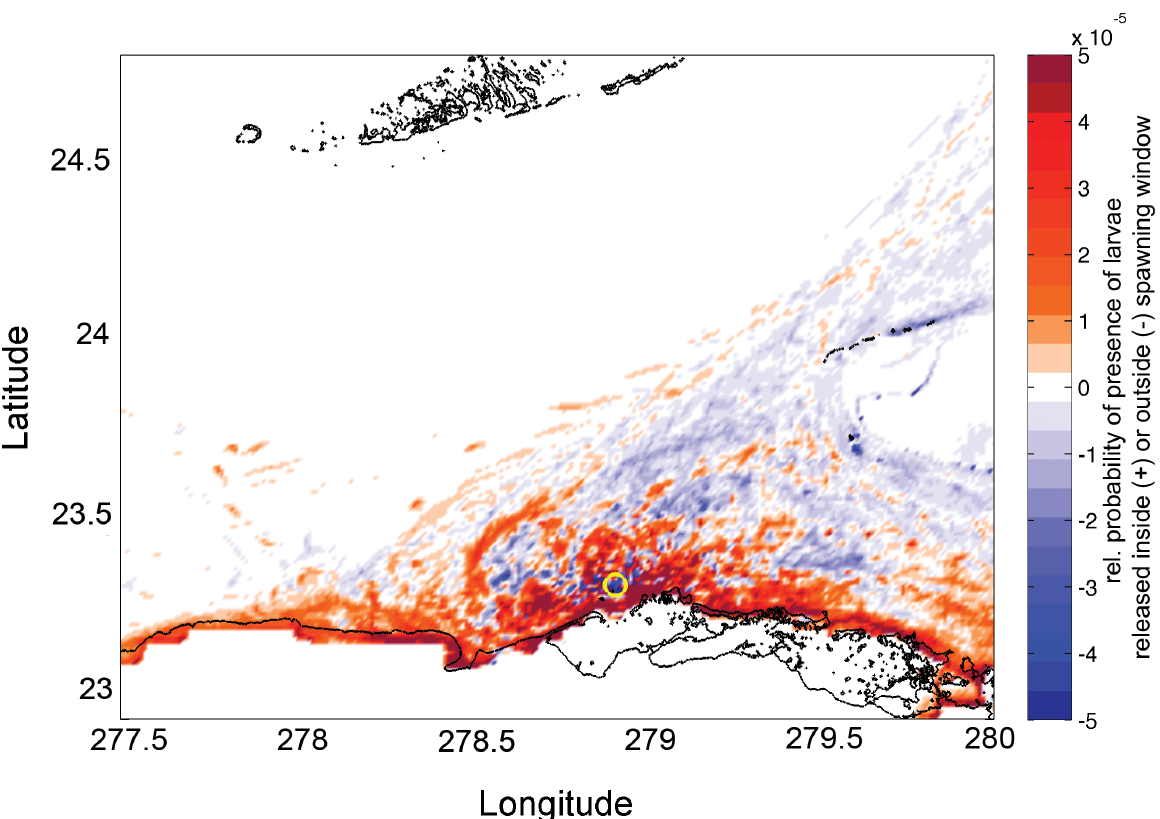
Fig 5. Difference in the dispersal kernels for larvae released inside and outside the spawning window. Color indicates the log of probability density of larval trajectories released inside and outside the spawning window; i.e., the probability that a larval particle released inside the spawning window was present in that grid cell minus the probability that a larval particle released outside the spawning window was present in that grid cell. A positive value (red) indicates that more larvae are present in the given grid cell when released within the spawning window. The yellow circle indicates the observed spawning